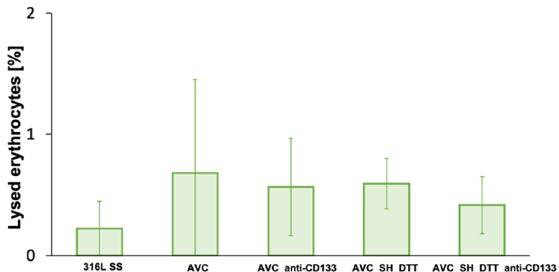
Figure 8. Hemolysis assay results. Erythrocytes lysed with 1% Triton X-100 were regarded as a 100% of hemolysis.